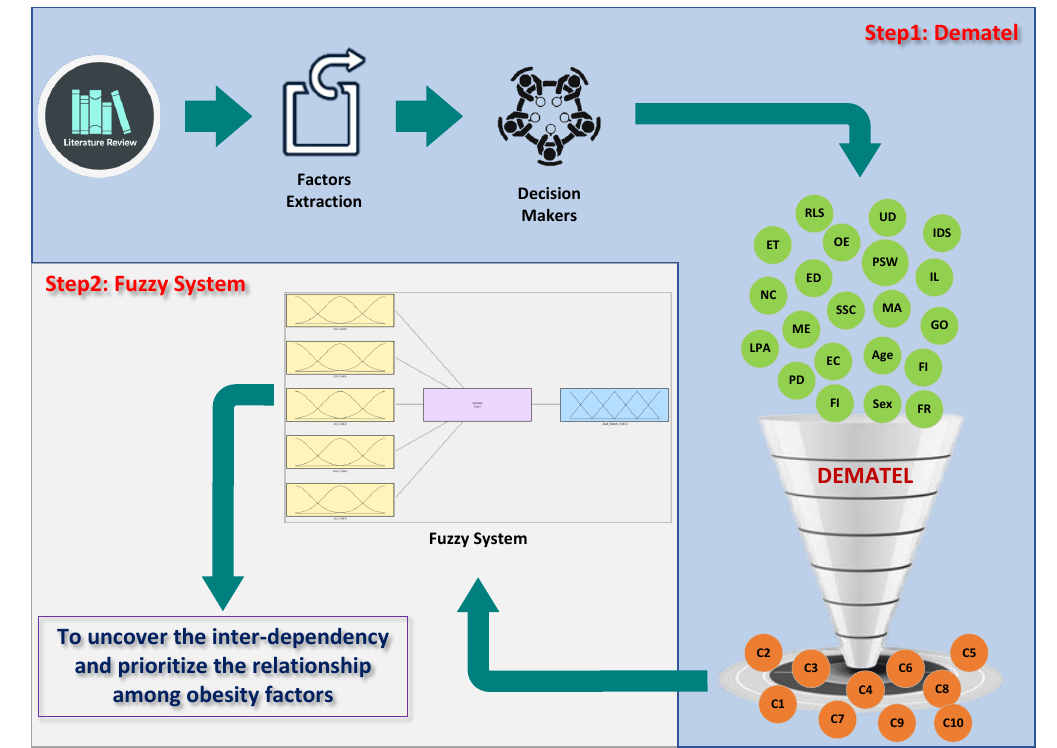
Figure 2. Proposed